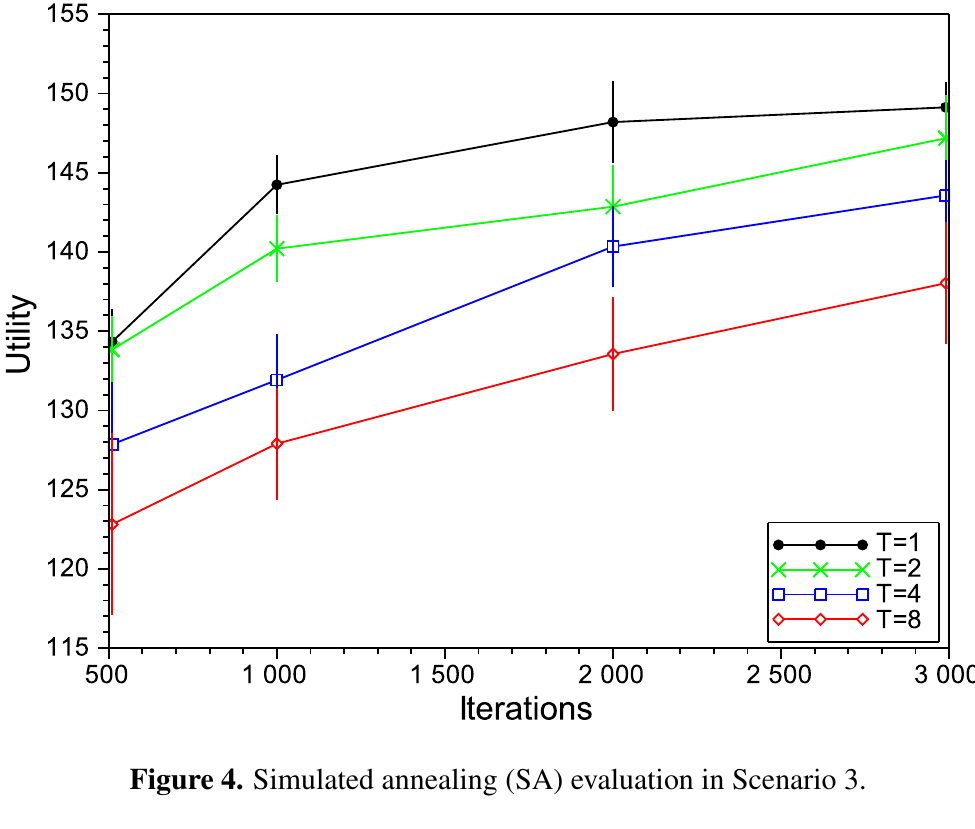
Figure 4. Simulated annealing (SA) evaluation in Scenario 3.